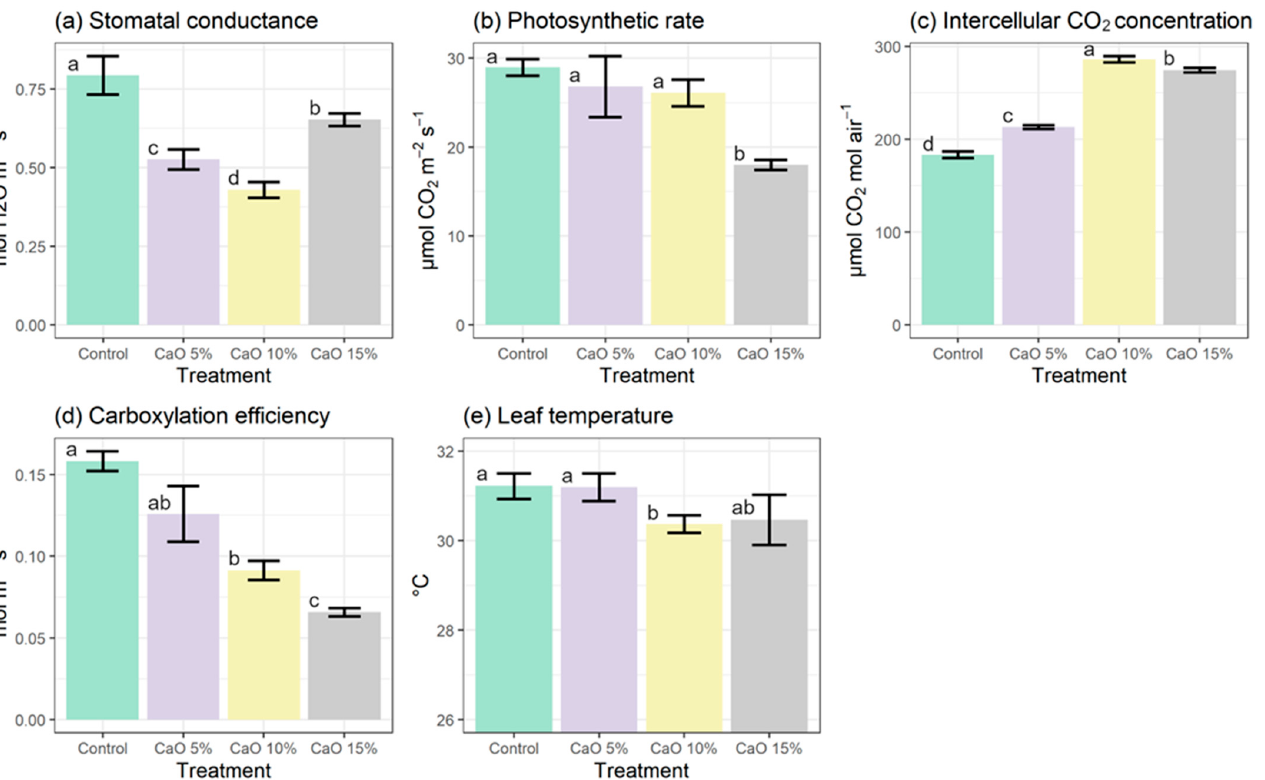
Figure 3. ( a ) Stomatal conductance ( F = 61.11; df = 3, 9; p < 0.0001), ( b ) photosynthetic rate ( F = 28.07; df = 3, 9; p < 0.0001), ( c ) intercellular CO 2 concentration ( F = 1078; df = 3, 9; p < 0.0001), ( d ) carboxylation efficiency ( F = 15.87; df = 3, 9; p < 0.0001), and ( e ) leaf temperature ( F = 5.21; df = 3, 9; p = 0.023) of sweet potato ( Ipomoea batatas L.) plants sprayed with calcium oxide (CaO) particle films at 5, 10, and 15% w/v and control (water). We performed measurements 30 days before harvesting using expanded leaves in the middle of the plant canopy. Values represent mean (±standard deviation), and bars followed by the same letter did not differ according to the Tukey test ( p < 0.05). ( n = 4).